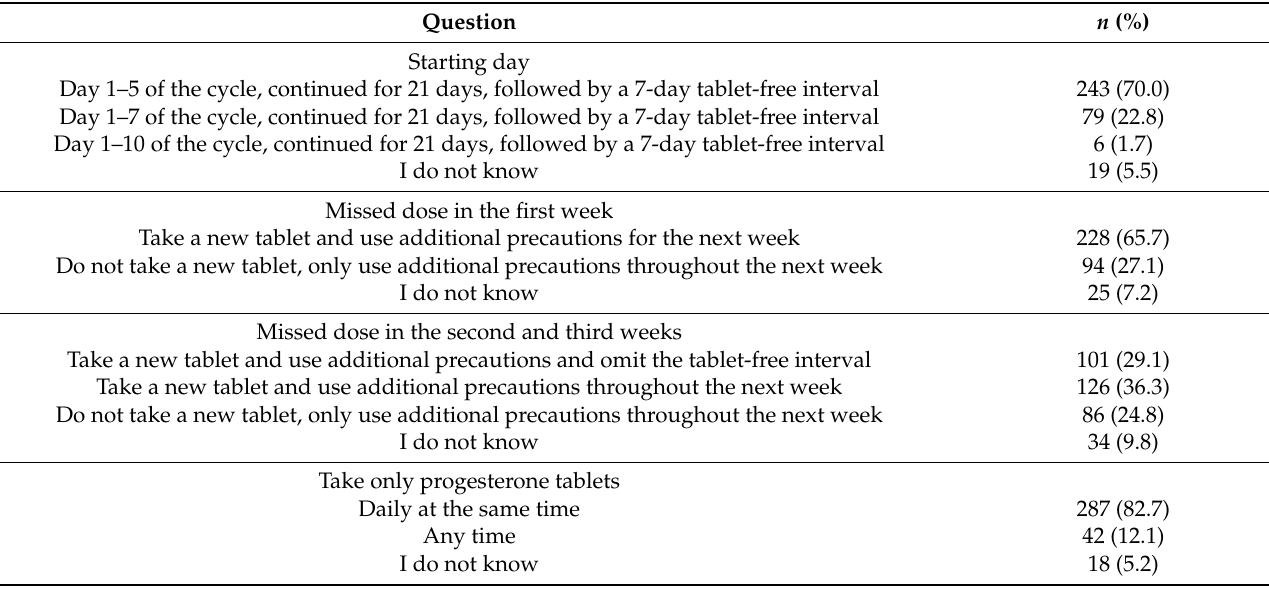
Table 3. Pharmacists’ knowledge about proper use and missed